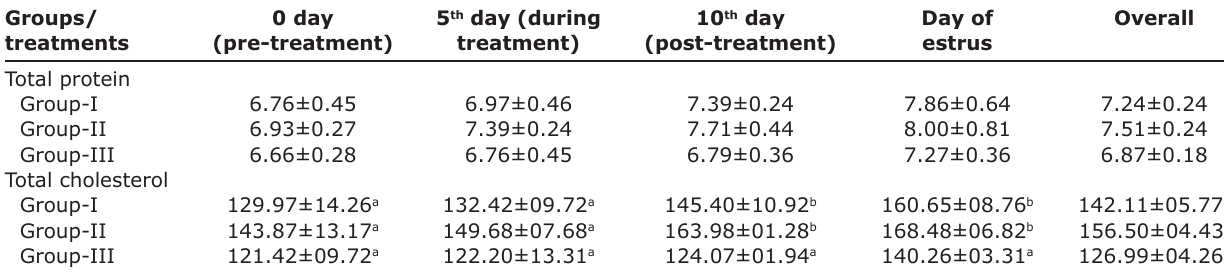
Table-1: Serum total protein (g/dl) and total cholesterol (mg/dl) levels at different time intervals/days in anestrous treated and control groups of buffaloes (Mean±SEM). Groups/ 0 day treatments